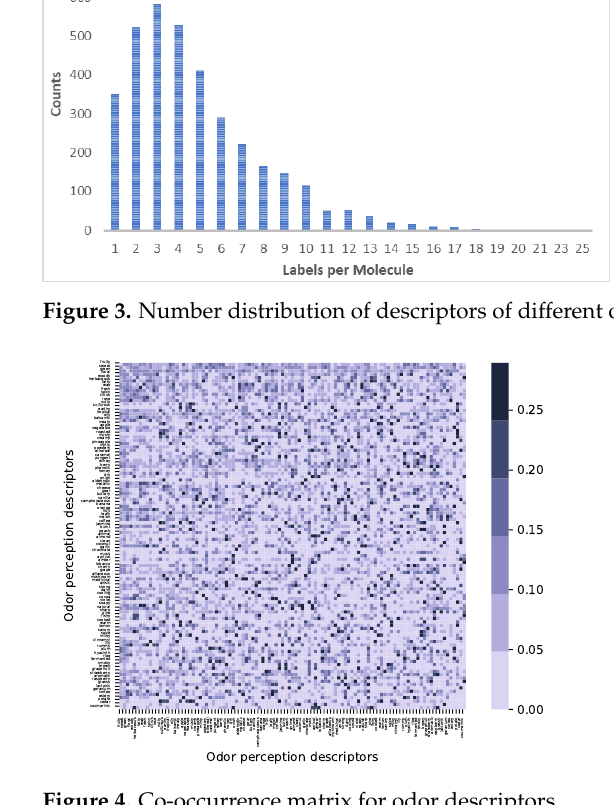
Figure 4. Co-occurrence matrix for odor